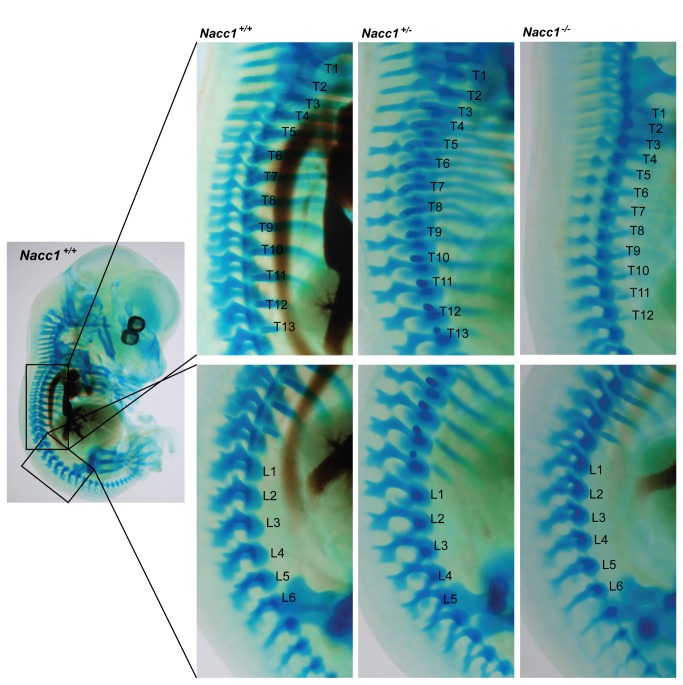
Reduced NAC1 expression is associated with altered specification of cartilage primordia for vertebral patterning.Comparison of representative Alcian blue-stained, whole mount mouse embryos at embryonic day 15 (E15) reveals the typical vertebral formulas related to the Nacc1+/+ (wild type, formula T13/L6), Nacc1+/- (heterozygous, formula T13/L5), and Nacc1-/- (knockout, formula T12/L6) genotypes. The numbers denote the number of vertebrae in the thoracic (T, top row) and lumbar (L, bottom row) regions of the vertebral column.